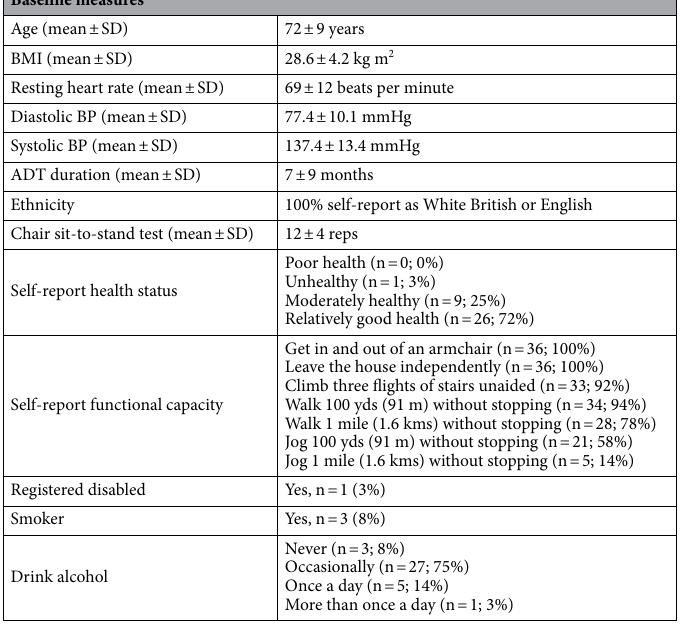
Table 1. Baseline characteristics of men on ADT in the STAMINA